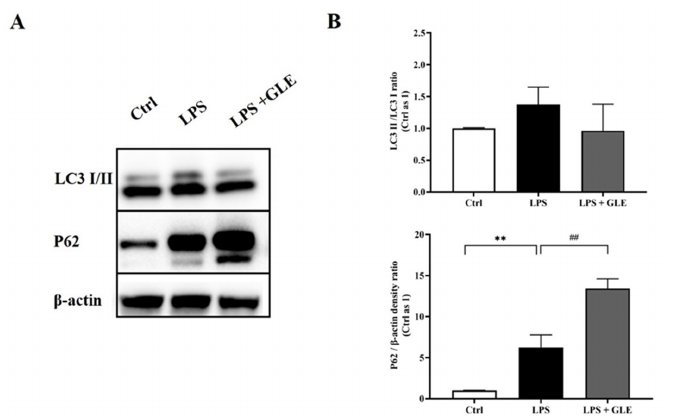
Figure 6. The effect of GLE on LC3 and P62 expression in LPS-induced BV-2 cells. ( A ) Representa- tive images of Western blot with antibodies against LC3B and P62. ( B ) Quantification analysis ofWestern blot. The immunoblotting of LC3B was analyzed by examining the LC3-I-to-LC3-II conversion, expressed as the LC3-II/LC3-I ratio. Values are represented in the form of mean ± SEM. **: p < 0.01, Ctrl group vs. LPS group; ##: p < 0.01, LPS group vs. LPS + GLE group. All experiments were repeated at least in triplicate.